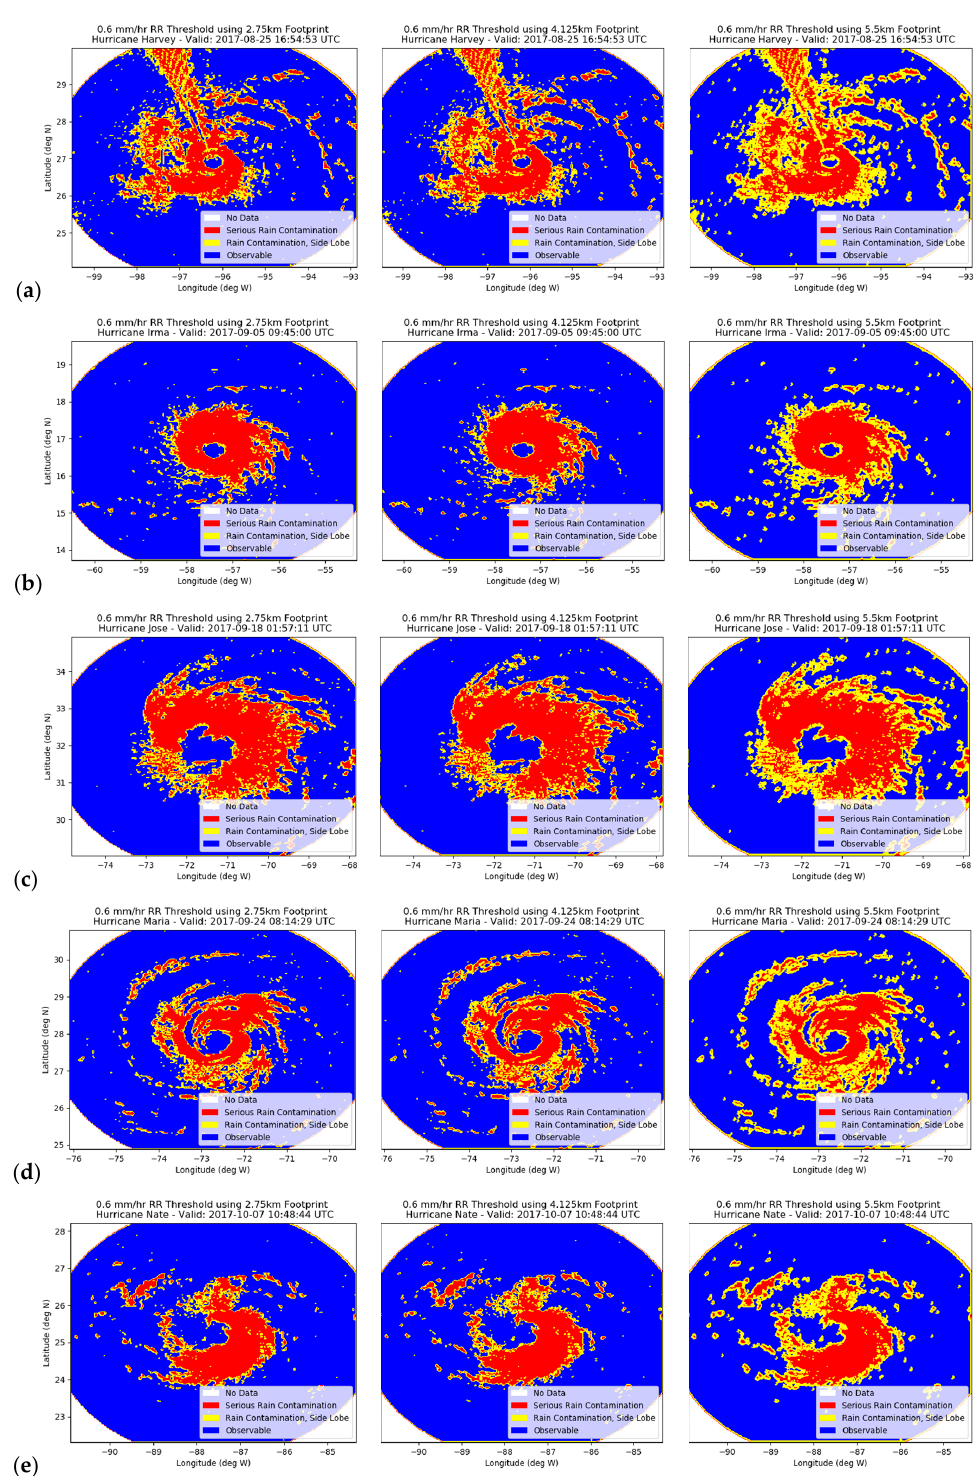
Figure 5. 0.1 mm/hr rain rate threshold applied to data for ( a ) Harvey-AL092017, ( b ) Irma-AL112017, ( c ) Jose-AL122017, ( d ) Maria-AL152017, and ( e ) Nate-AL162017. Rain rates at or below the threshold and surface observable ( blue ), rain rate at or below the threshold but surface not observable due to problems somewhere in the footprint ( yellow ), and rain rate exceeds the threshold ( red ).